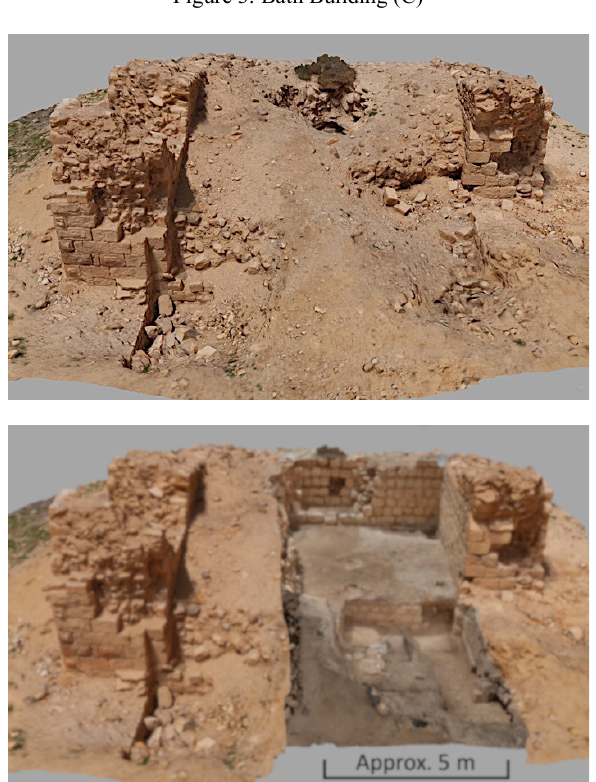
Figure 4: 3D textured mesh model of building A, above in 2016, below superimposition of 2017 excavation.